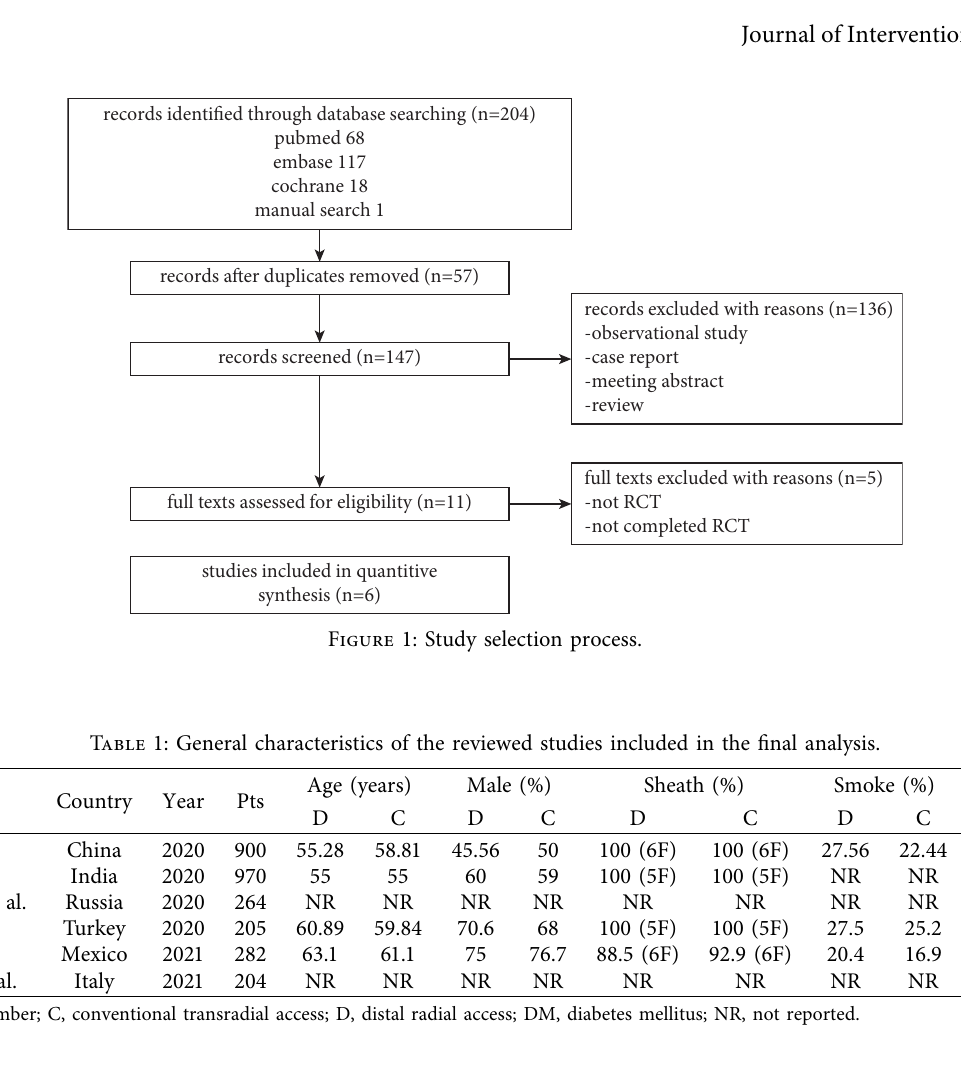
Table 2: Internal validity of the included RCTs ∗ .